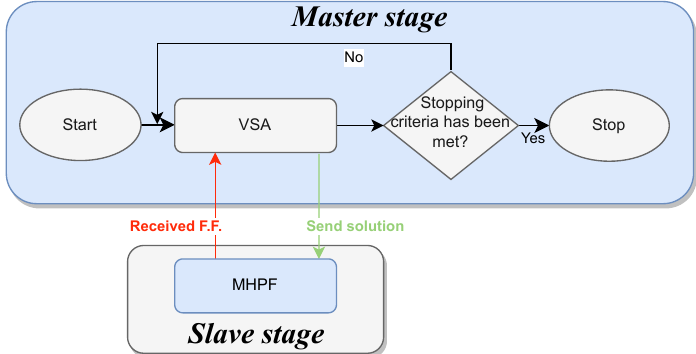
Figure 2. Master–slave methodology proposed.